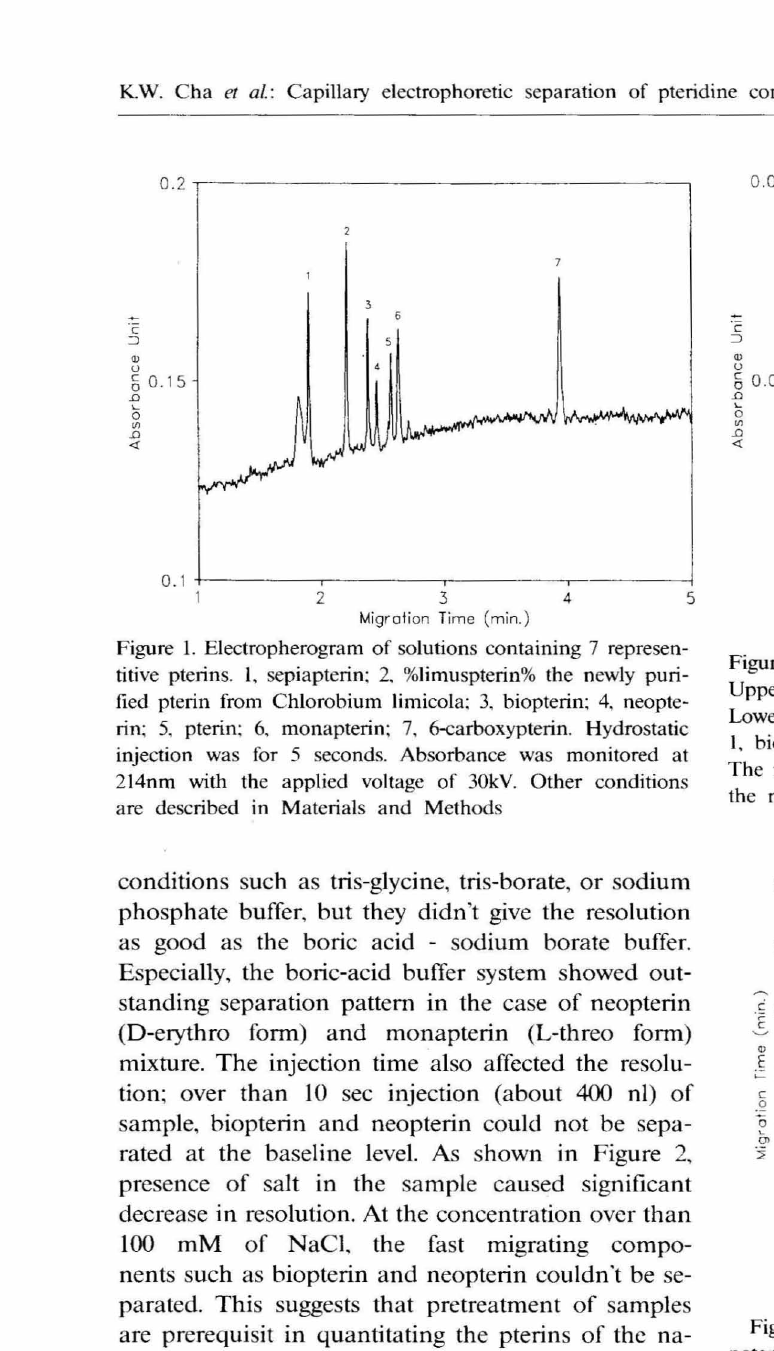
Figure 3. Elution time of pteridines as a function of applied potential: ( • ) biopterin; ( 0 ) neopterin: ( ... ) monapterin: ( * ) ~arboxypterin